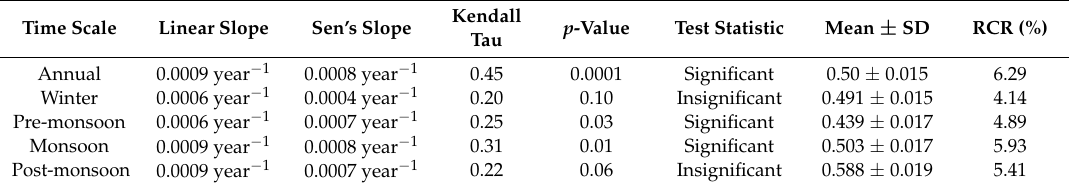
Table 1. Annual and seasonal NDVI slope, Mann-Kendall test statistic, mean NDVI and Relative Change Ratio (RCR) in Nepal,